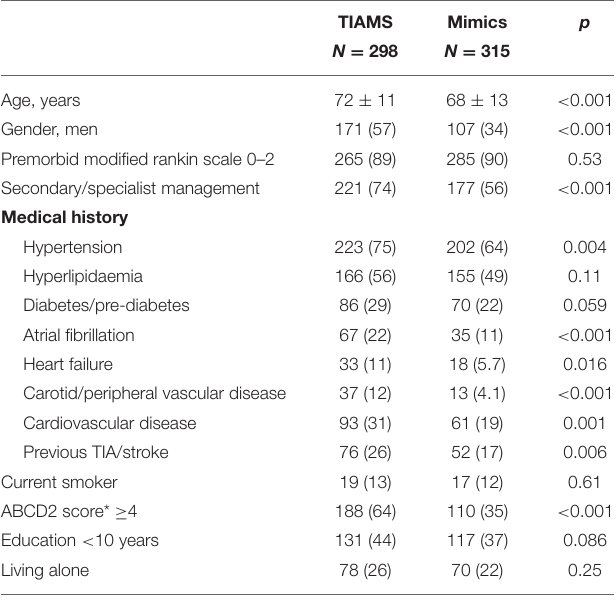
subarachnoid hemorrhage were recorded. Non-responders